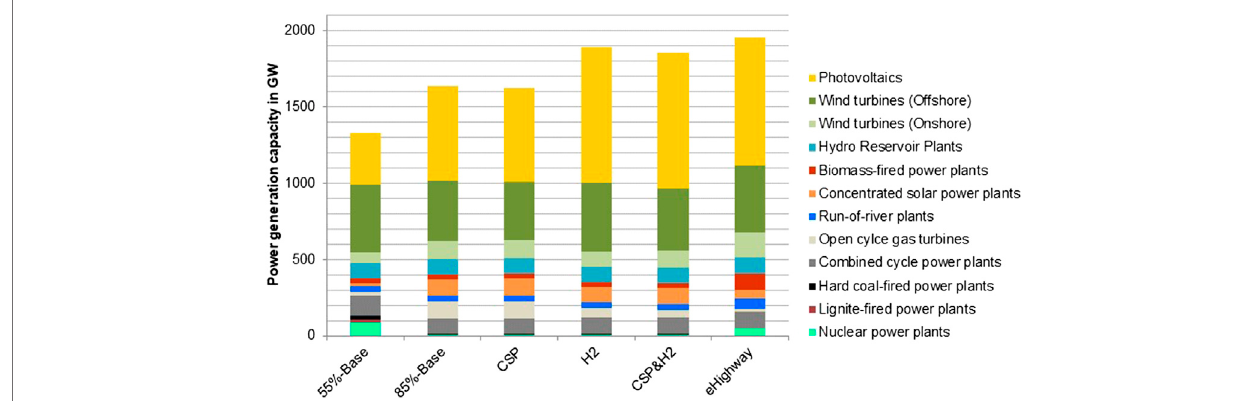
FIGURE 3 | Power generation mixes for several European narrative scenarios.